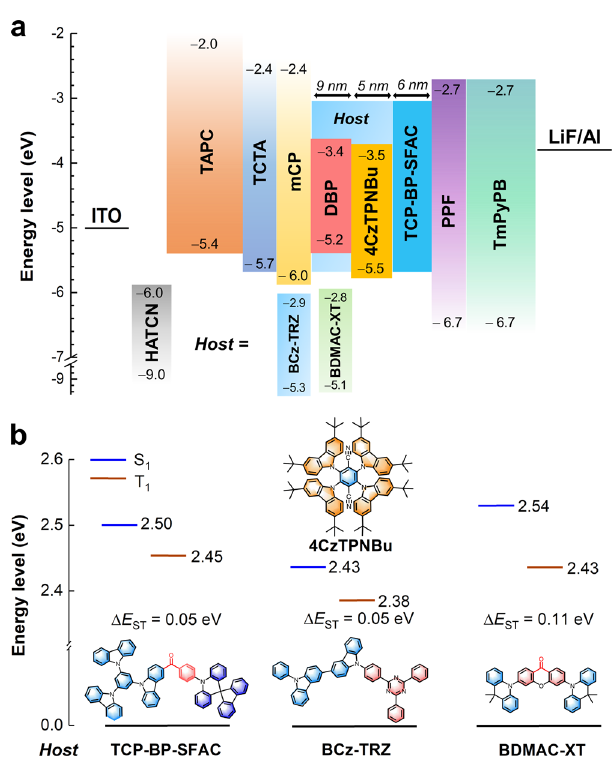
Fig. 6 | Device data and energy levels for host-tuning effect study. a Device con fi gurations of devices WS5 – WS7. b Singlet and triplet energy levels of